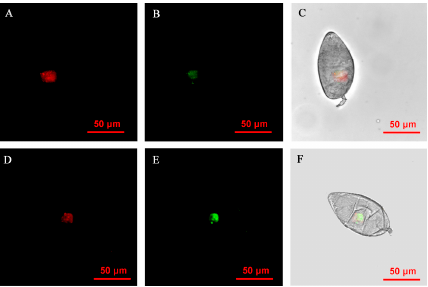
Figure 6. FISH visualization of Wolbachia and Ricke tt sia in egg stages (96–120 h) of B. tabaci. Locali- zation of symbiotic bacteria Ricke tt sia (red) and Wolbachia (green) in the B. tabaci eggs at di ff erent times (( A – C ): 96 h, ( D – F ): 120 h). Ricke tt sia fl uorescence ( A , D ) and Wolbachia fl uorescence ( B , E ) are displayed in dark fi eld; W olbachia and Ricke tt sia fl uorescence ( C , F ) is displayed in bright fi eld.